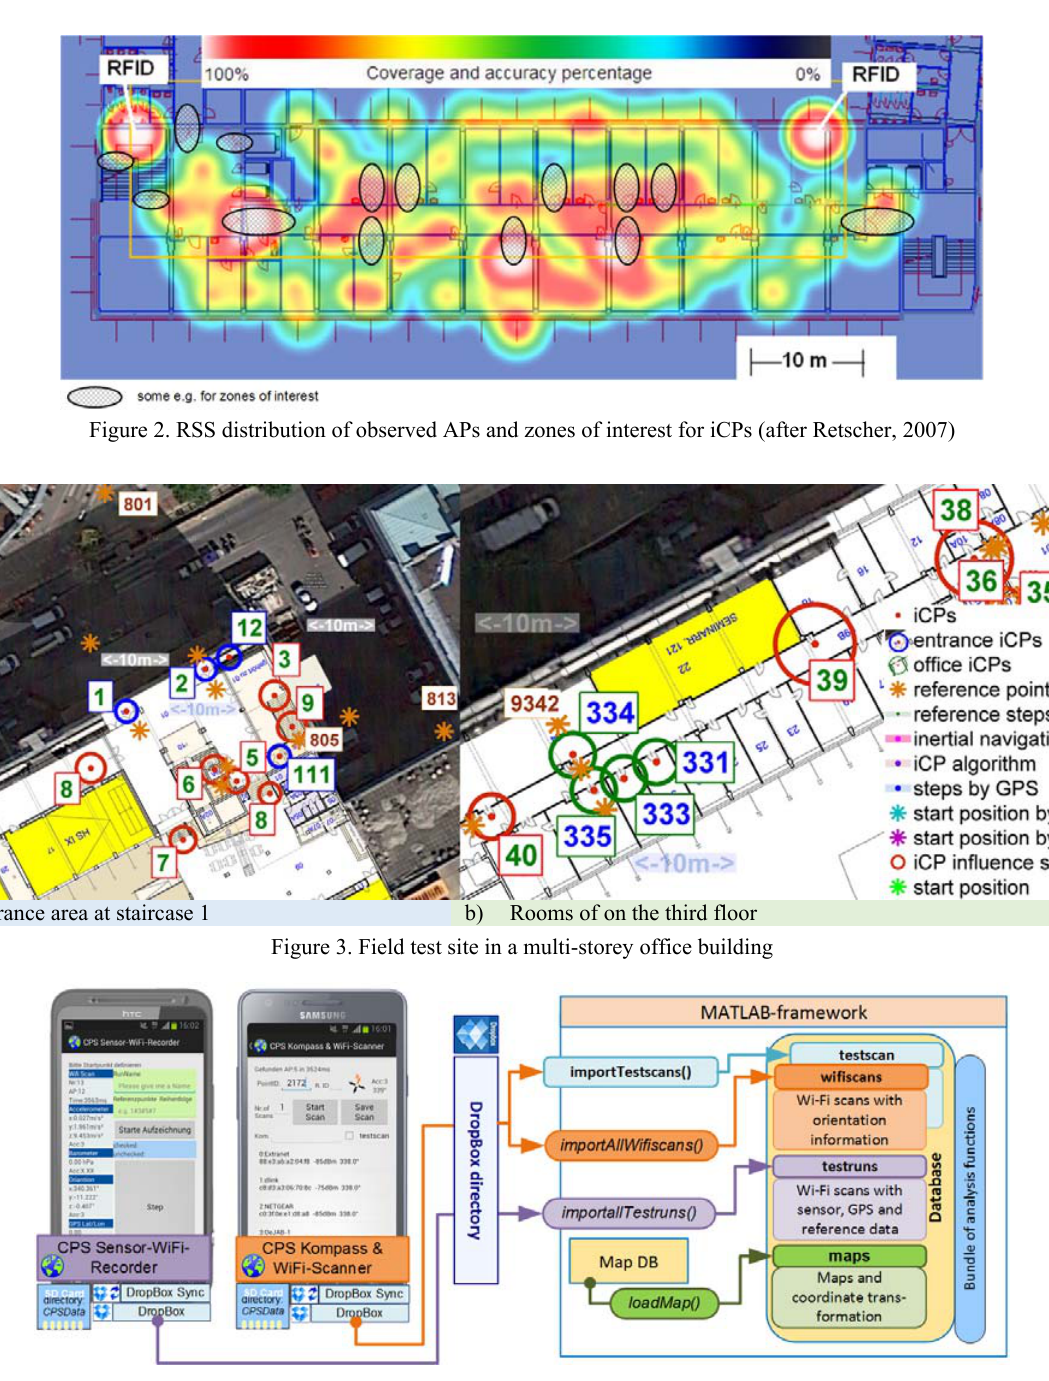
Figure 4. Overview of the main components of the